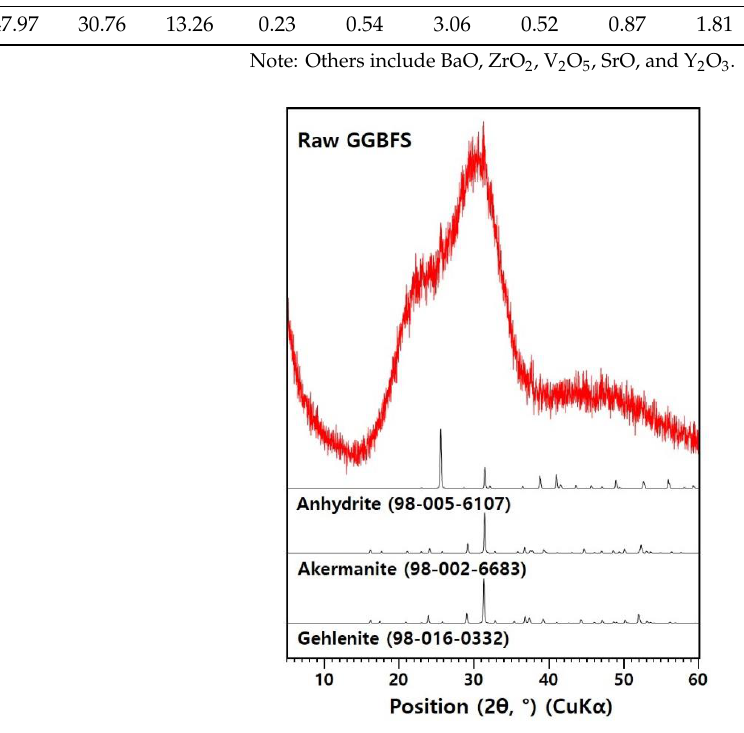
ff raction (XRD) patterns of raw Figure 1. X-ray diffraction (XRD) patterns of raw GGBFS. Figure 1. X-ray di